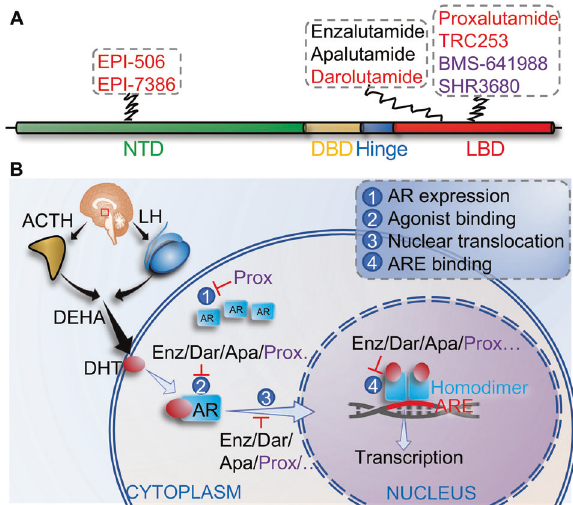
Fig. 2 The binding location of AR antagonists and roles in inhibition of AR-mediated transactivation. A All of the FDA- approved second-generation AR antagonists bind to the ligand- binding domain (LBD). Potential AR antagonists including proxaluta- mide (Prox), TRC253, BMS-641988, and SHR3680 bind to the LBD, while EPI-506 and EPI-7386 bind to the N-terminal domain (NTD). Among these AR antagonists, EPI-506 and EPI-7386, darolutamide, proxaluta- mide, and TRC253 can bind with AR harboring mutations such as F876L. B All of the AR antagonists that bind to the LBD can competitively inhibit DHT binding to AR, as well as AR nuclear translocation and binding to DNA and coactivators. Binding of EPI-506 and EPI-7386 to the NTD of AR can inhibit AR transcriptional activation. Of note, proxalutamide can also repress AR protein